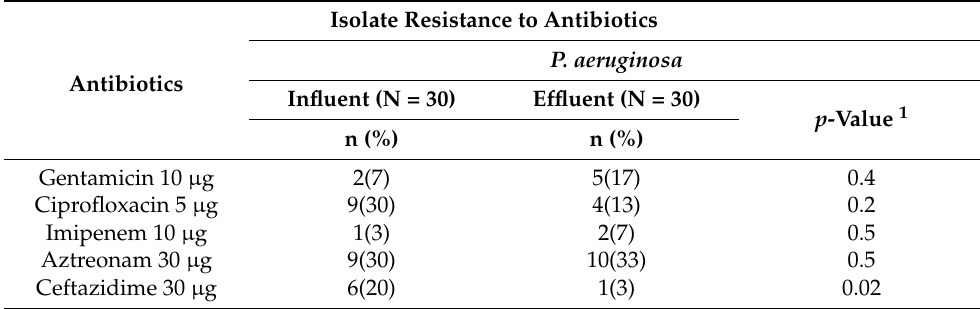
Table 3. Antibiotic resistance of P. aeruginosa in influent and effluent wastewater from the Legon Sewage Treatment Plant, Accra, Ghana (January to June